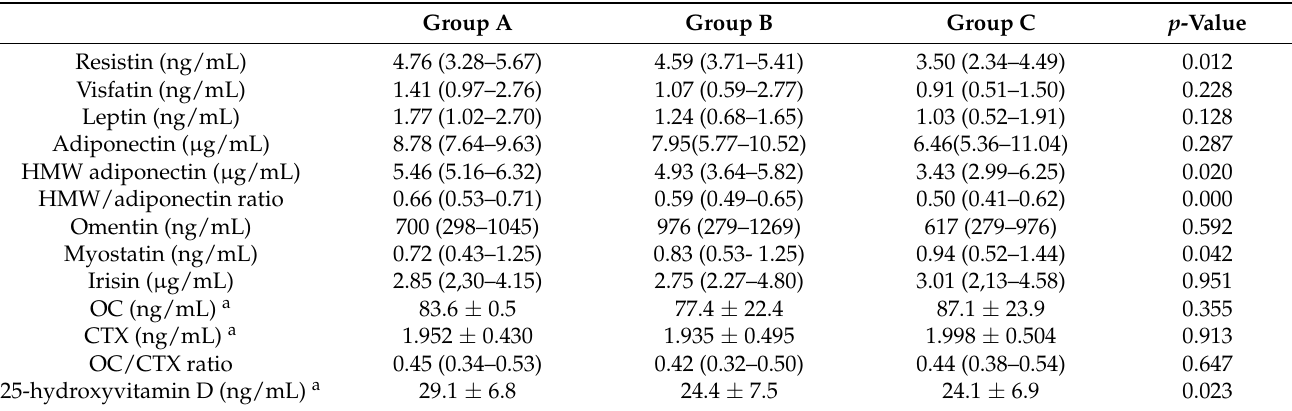
Table 2. Serum concentrations of myokines, adipokines and bone metabolism markers in the studied groups of children. Group